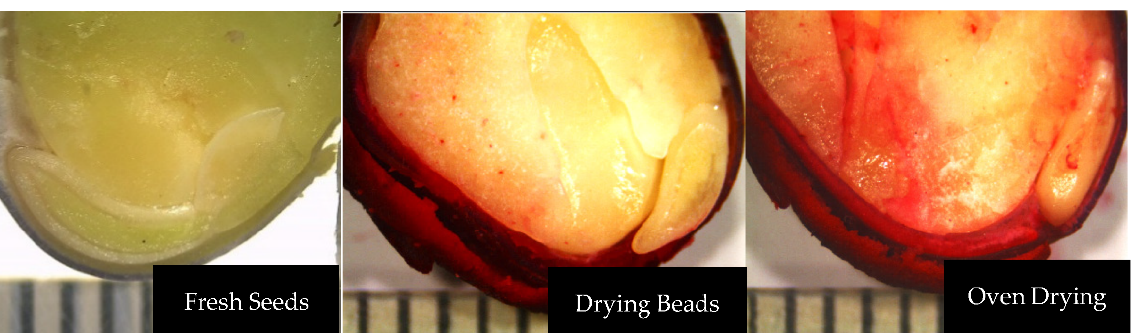
Figure 2. Comparison of the seed membrane integrity of freshly harvested seeds with seeds subjected to two different drying methods (with drying beads, membrane integrity was less reduced, and with oven drying, membrane integrity was greatly reduced).